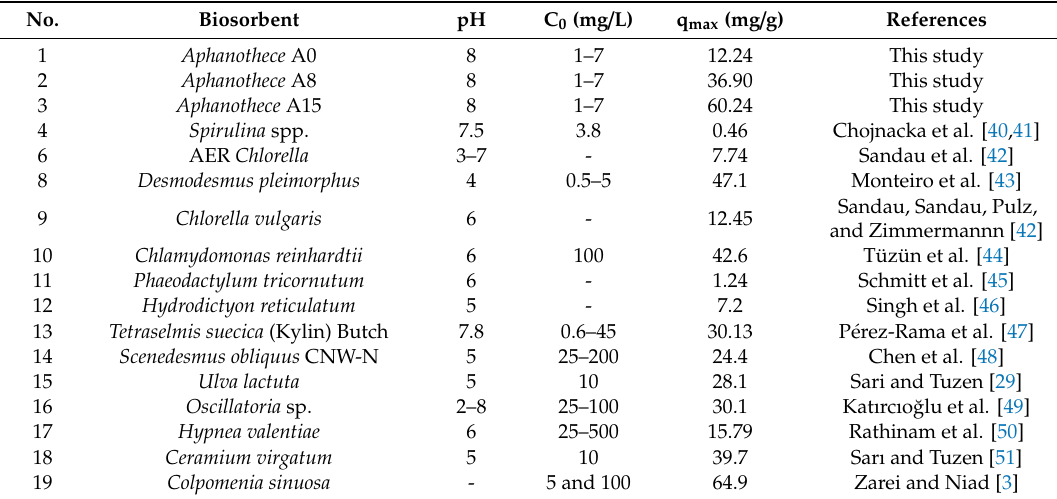
Table 6. Comparison of maximum sorption capacity of Aphanothece sp. to other algae-based biosorbents.